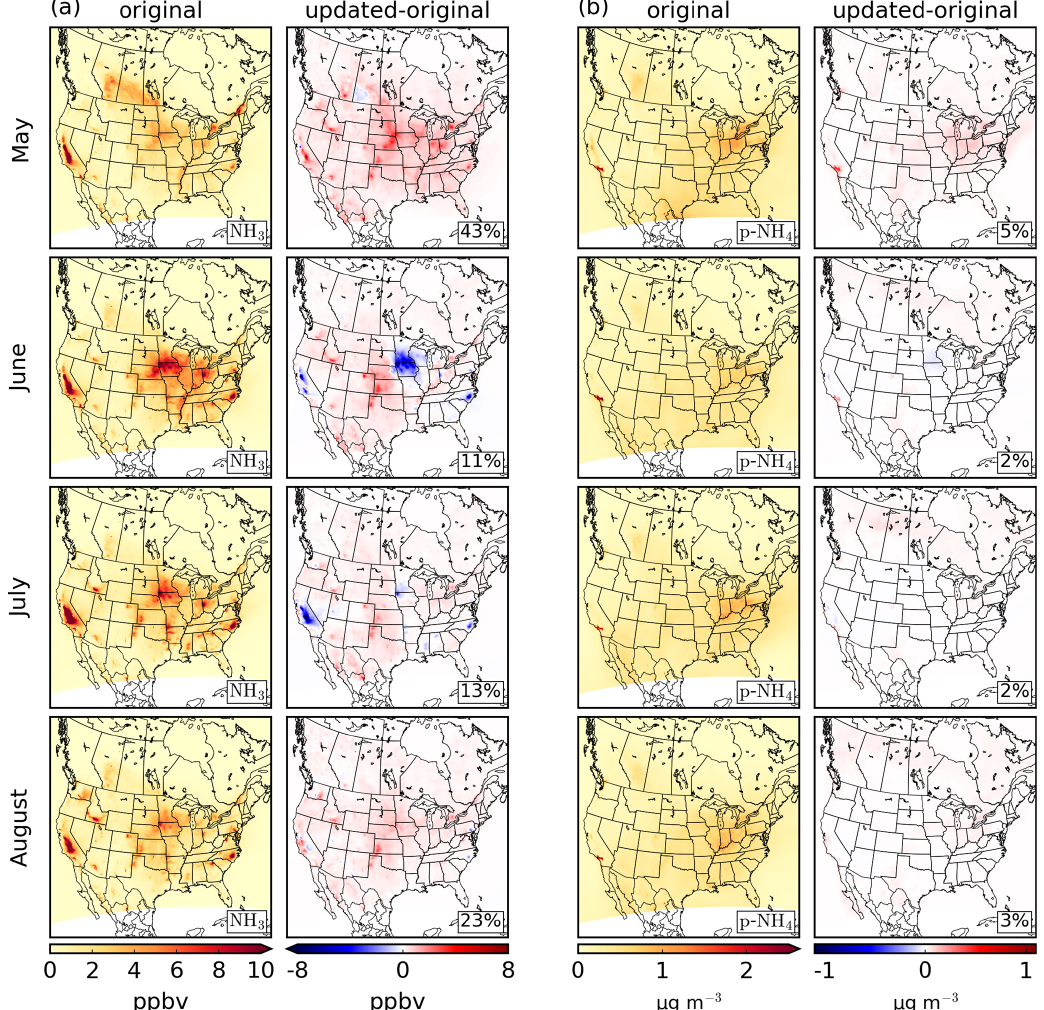
Figure 5. Monthly mean surface (a) NH 3 VMR and (b) p-NH 4 concentration fields from GEM-MACH for May to August 2016. In panels (a) and (b) , the left columns show the mean surface field when the original ammonia emissions are used, and the right columns show the mean difference between the GEM-MACH runs with the updated ammonia emissions from the inversion and the original emissions. For plots in the right columns, the total difference over the model domain as a percentage of the original field is shown in the lower right corner. Plots for p-NH 4 show the total ammonium mass over both aerosol size